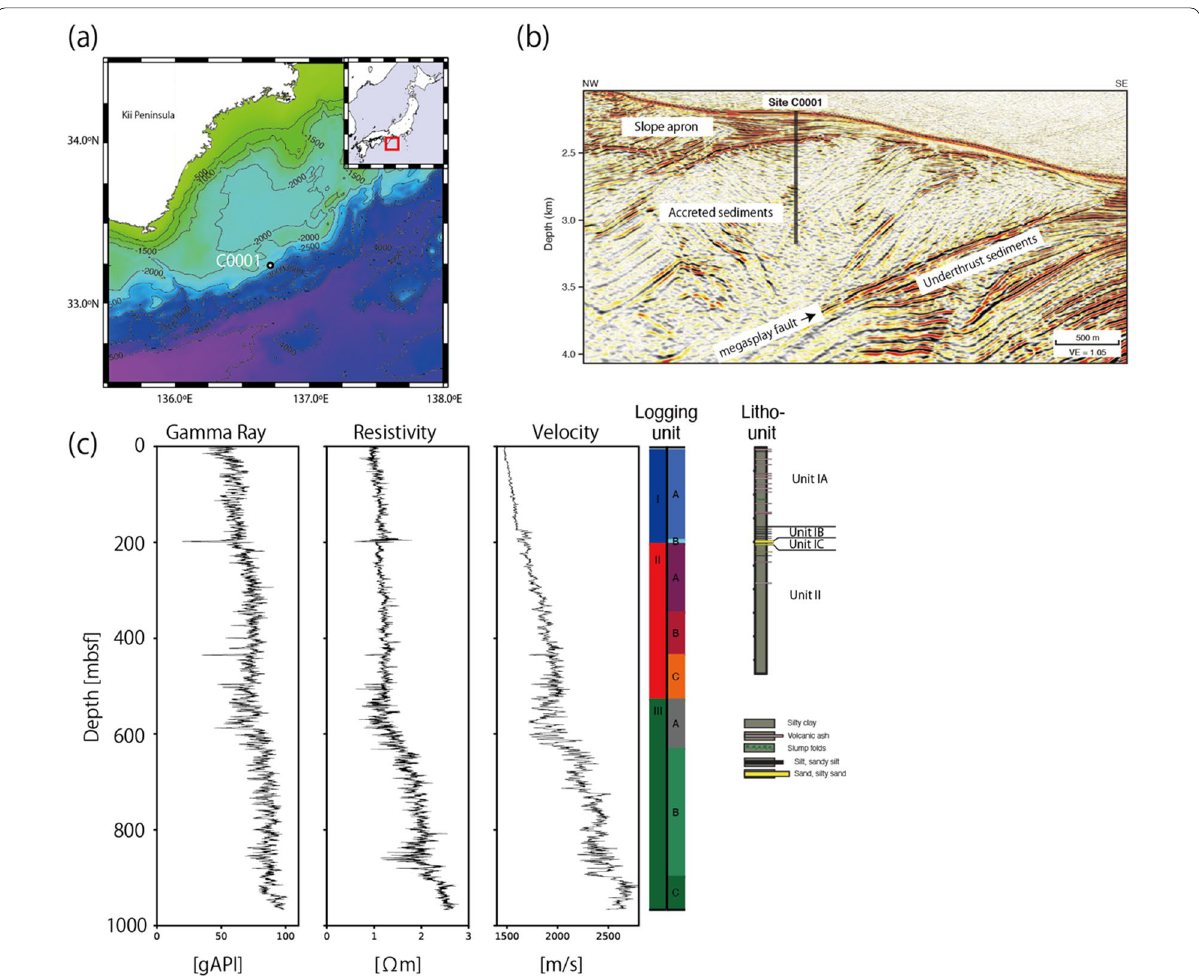
Fig. 2 Geological settings and data summary at Site C0001. a Regional map off the Kii Peninsula, Japan, showing the location of Site C0001. b Local seismic reflection image after Expedition 314 Scientists (2009b). c Logging data and previously reported log‑ and litho‑units (Expedition 314 Scientists 2009b; Expedition 315 Scientists